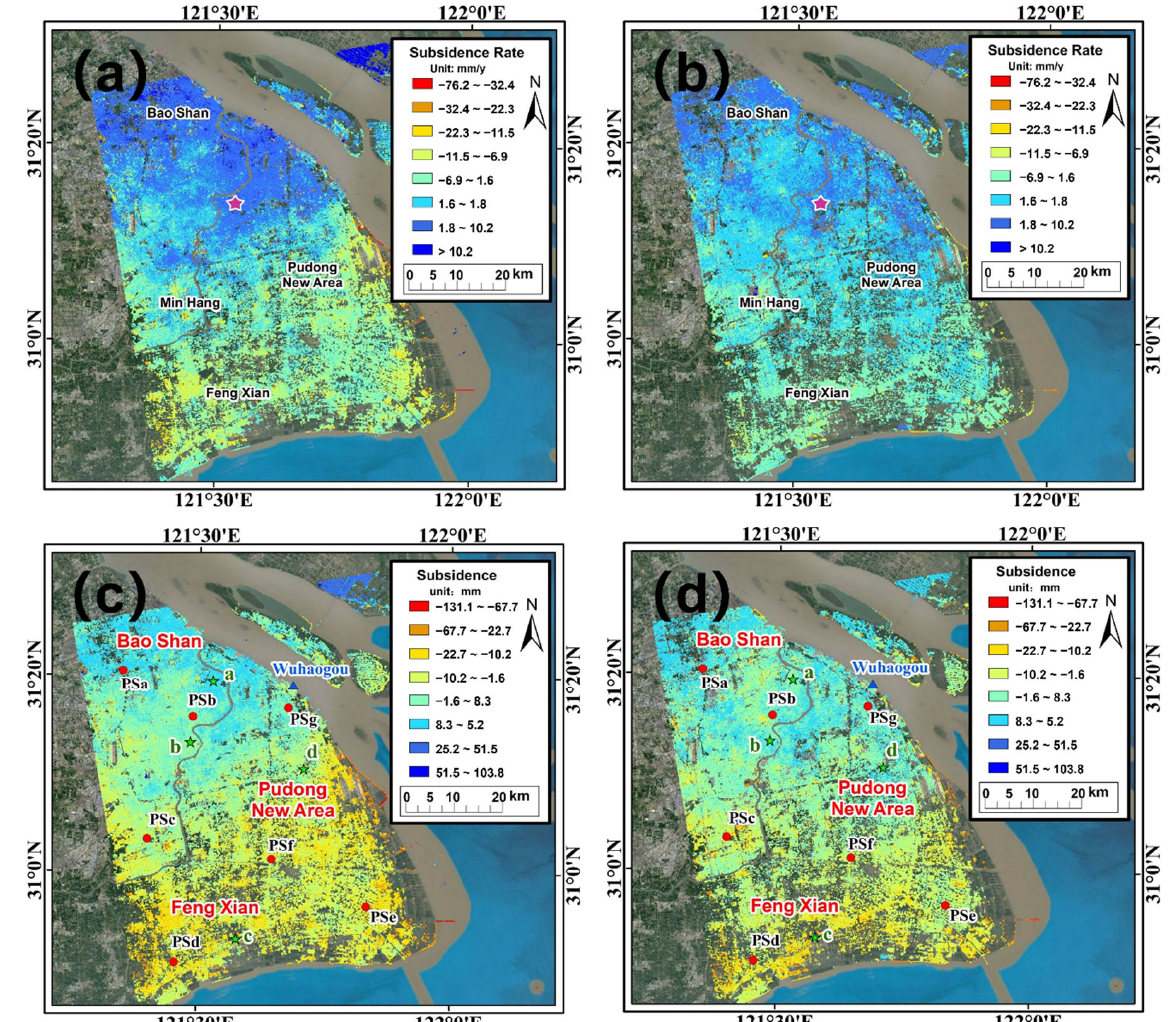
Figure 5. Subsidence in the Shanghai area. ( a ) Surface subsidence rate in Shanghai from May 2016 to December 2017; ( b ) surface subsidence rate in Shanghai from January 2018 to December 2020. The red star is the reference point of data processing; ( c ) cumulative surface subsidence in Shanghai from May 2016 to December 2017; ( d ) cumulative surface subsidence in Shanghai from January 2018 to December 2020. The purple pentagram is the reference point.